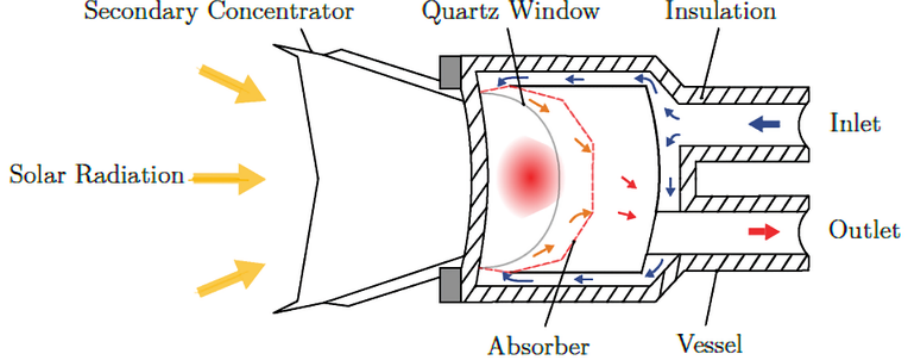
Figure 2. Scheme of the pressurized volumetric receiver. Adapted from [28].